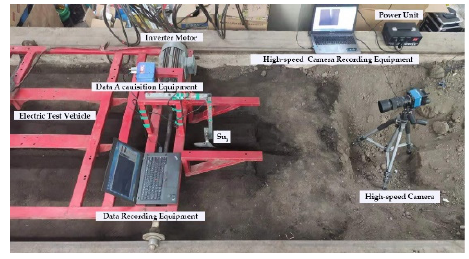
Figure 11. Su 3 experiment of soil bin.